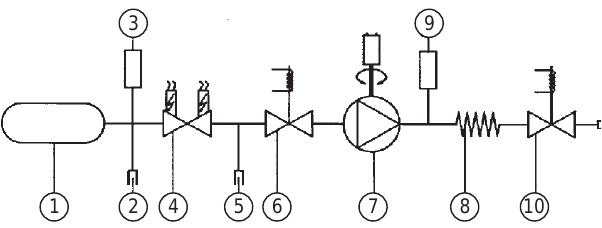
Fig. 4. Gas flow control system: ( 1 ) gas bottle, ( 2 ) filling nipple, ( 3 ) pressure transducer, ( 4 ) pyro valve, ( 5 ) test port connection, ( 6 ) latching valve, ( 7 ) motor-driven pressure regulator, ( 8 ) constant leak, ( 9 ) pressure transducer, ( 10 )